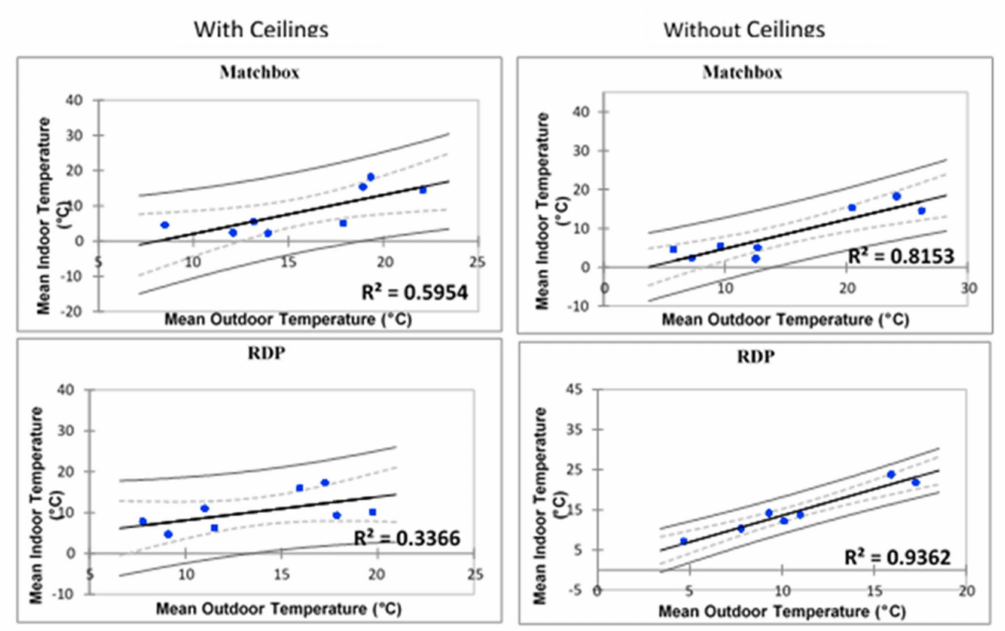
Figure 13. Regression models comparing homes with ceilings (left) and those without (right) of match box and RDP types in Wakkerstroom (with a 95% confidence